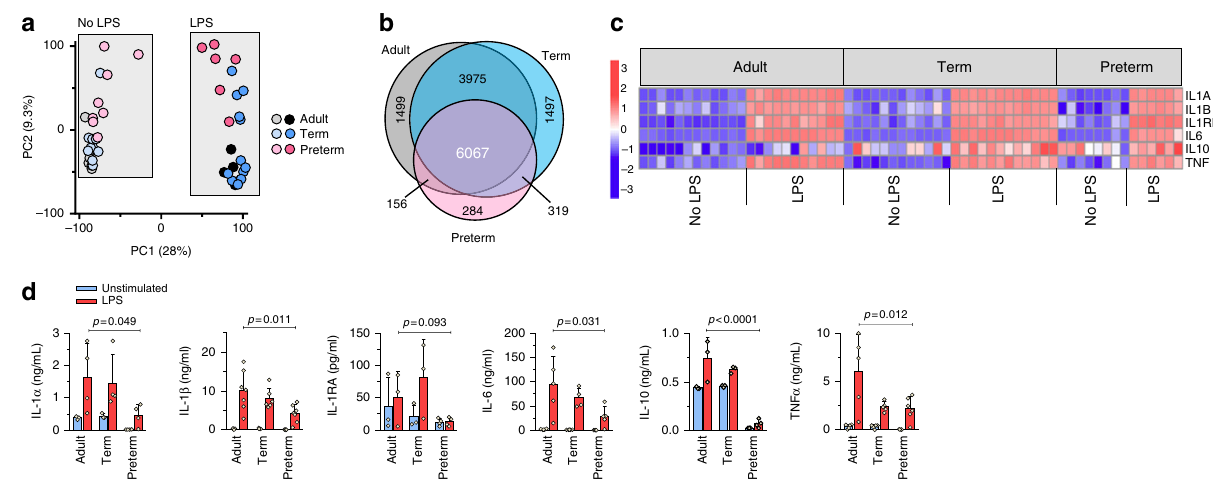
Fig. 4 Transcriptome and cytokine responses to LPS in neonatal monocytes. a Principal component (PC) analysis of unstimulated versus LPS-stimulated monocytes and b Venn diagram of differentially expressed genes (LPS-stimulated samples) overlapping between age groups (FDR 5%). c Expression heatmap of cytokine genes (5 h LPS; scale = z -score) Data from same subjects as in Fig. 3, except for 1 adult and 2 preterm subjects with insuf fi cient cells for LPS condition; d Production of cytokines following LPS stimulation (24 h, mononuclear cells) by ELISA (effect of age by two-way ANOVA; mean ± SD; n